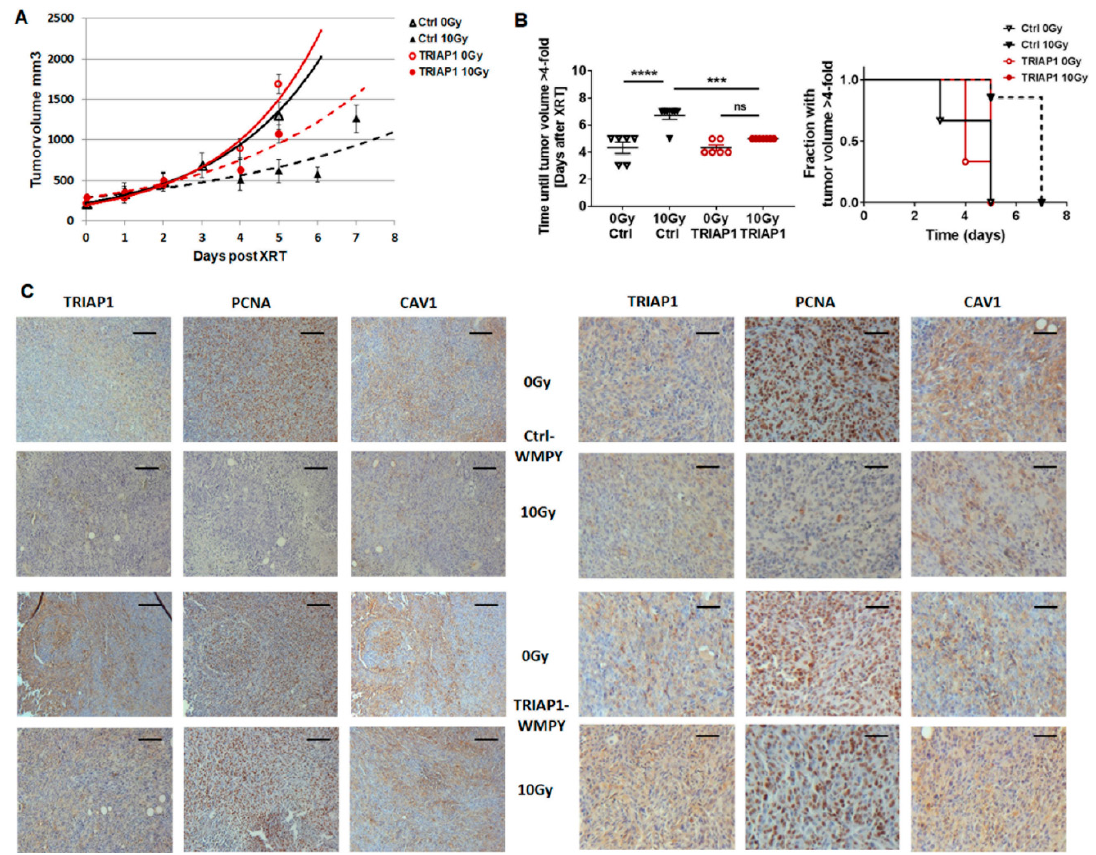
Figure 4. TRIAP1 expression in fibroblasts fosters radiation resistance in tumours derived from PC3 CAV1(-)